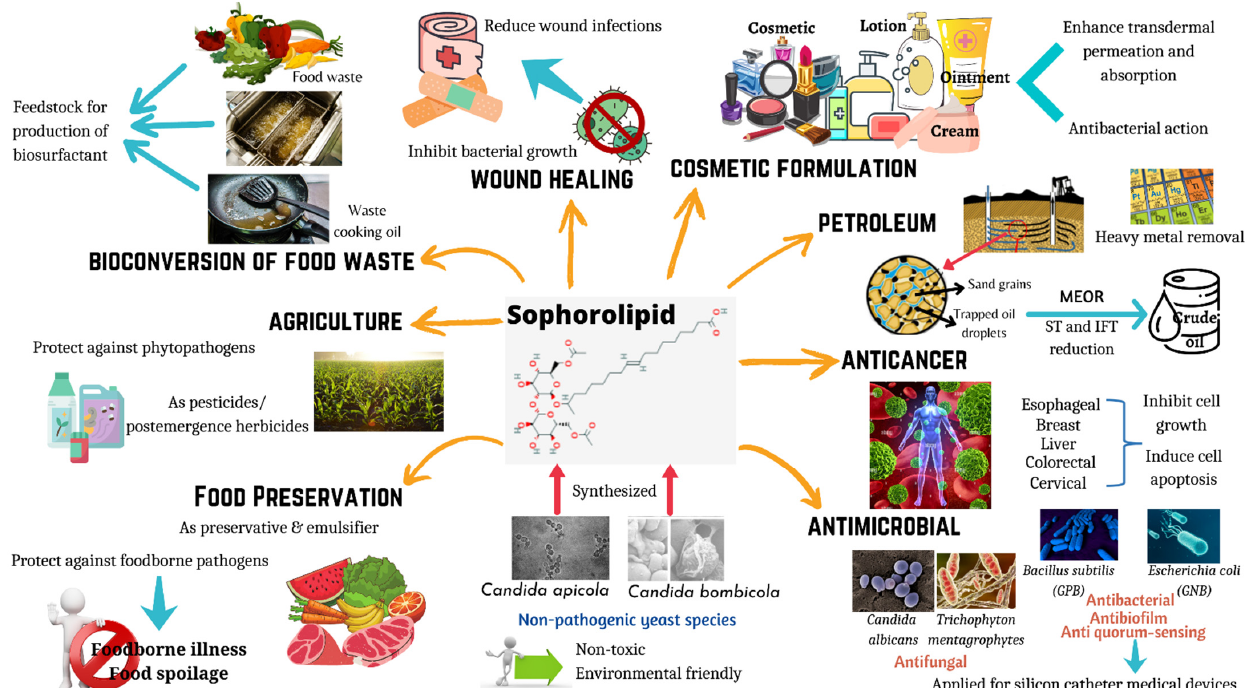
Figure 1. Applications of sophorolipids in food and health. Sophorolipids are synthesized by non-pathogenic yeast species, and they have the potential to be used in wide range of applications including wound healing, cosmetic formulations, anticancer agents, antimicrobial agents, food preservation, food waste management, and agriculture practices.